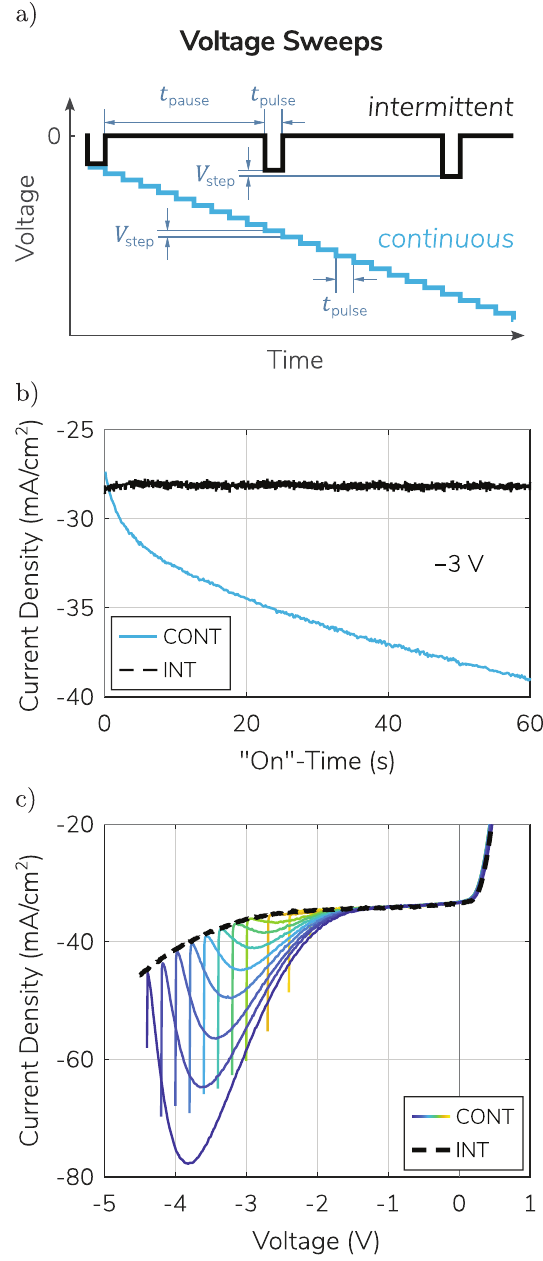
Fig. 2. Suppressing sample heating with intermittent voltage sweeps. (a) Sketch of the two types of voltage sweeps. (b) Evolution of the current density upon application of a constant reverse voltage of (cid:3) 3 V under illumination of one sun (INT with t pause =1.5 s). (c) Continuously swept reverse-IV measurements (up-sweeps) starting from different voltages (solid coloured lines) in comparison with an intermittently swept measurement (dashed black line, t pause = 1.0